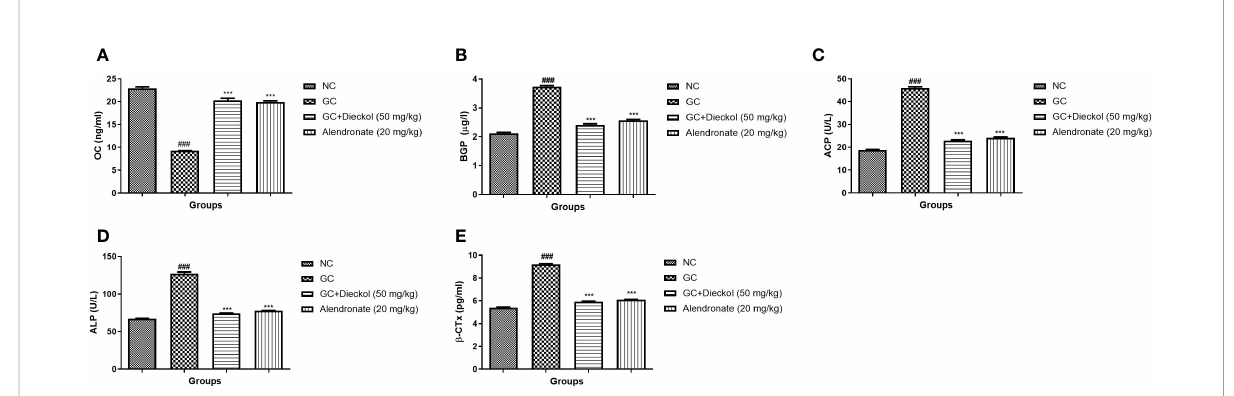
FIGURE 3 Dieckol was found to have an anti-glucocorticoid – induced osteoporosis effect on biochemical parameters in rats. (A) OC, (B) BGP, (C) ACP, (D) ALP, and (E) b -CTx. Results are shown as means ± SEM (n = 12). ***P < 0.001 when contrasted with the disease group and the normal